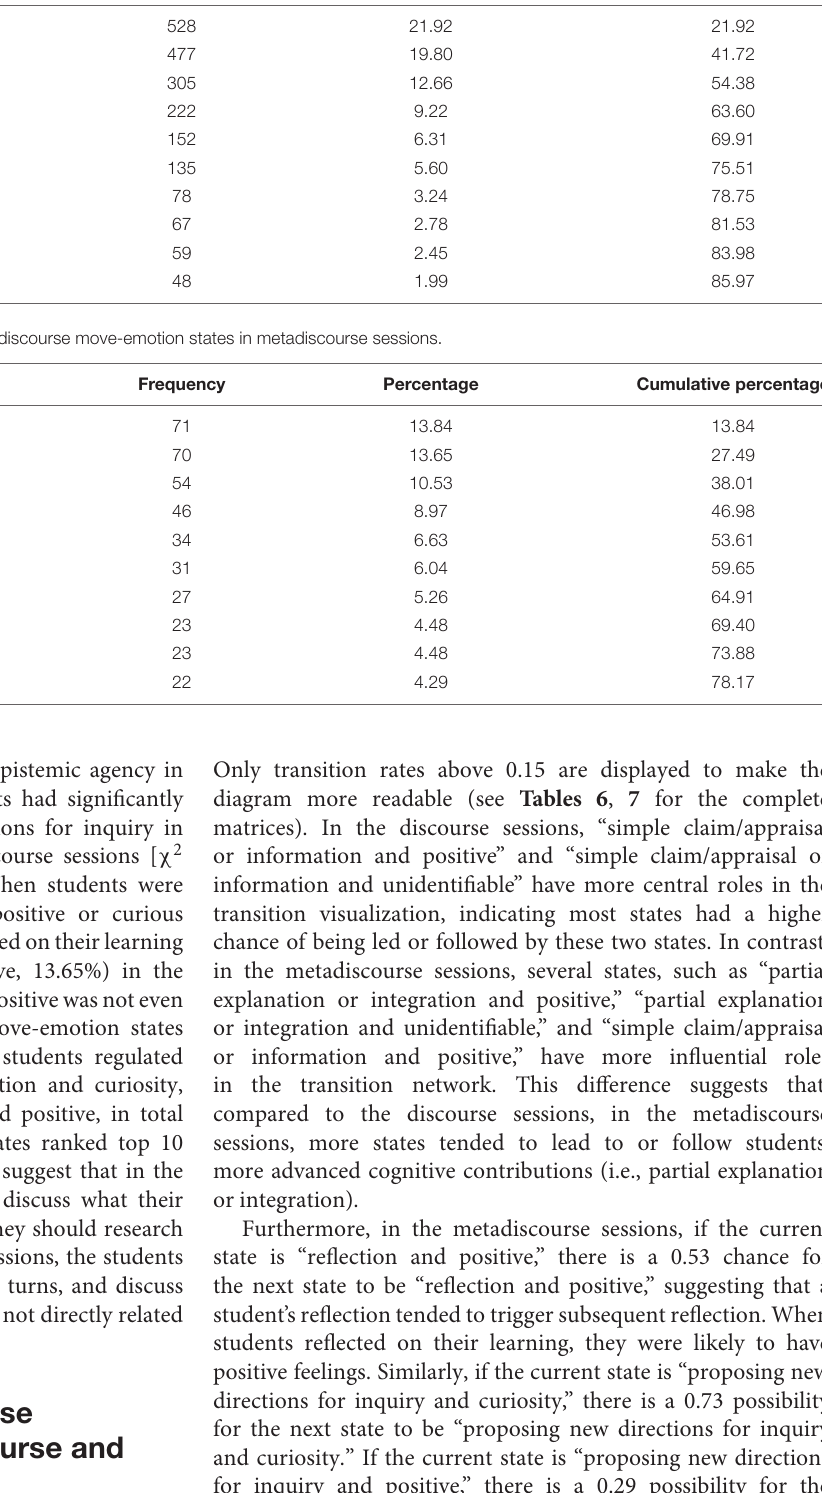
TABLE 4 | The descriptive data of the 10 most occurring discourse move-emotion states of discourse sessions. Discourse move-emotion pair Frequency